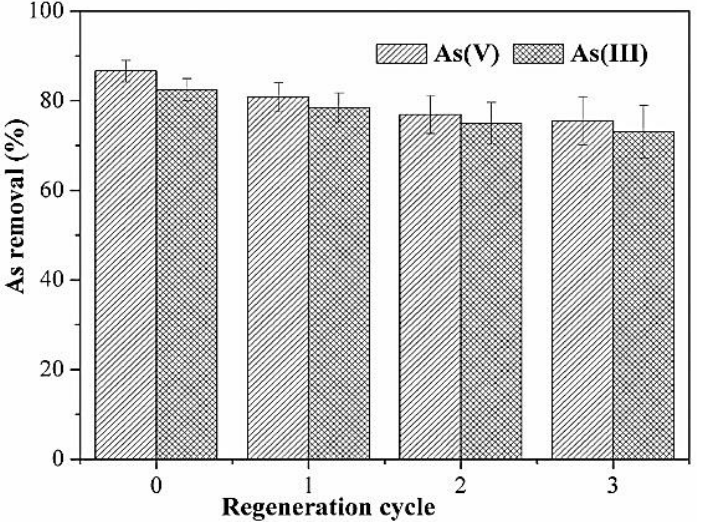
Figure 10. Regeneration of MnO 2 -modified activated carbon. Reprinted from Wang et al. [46] Copyright 2021 Elsevier.